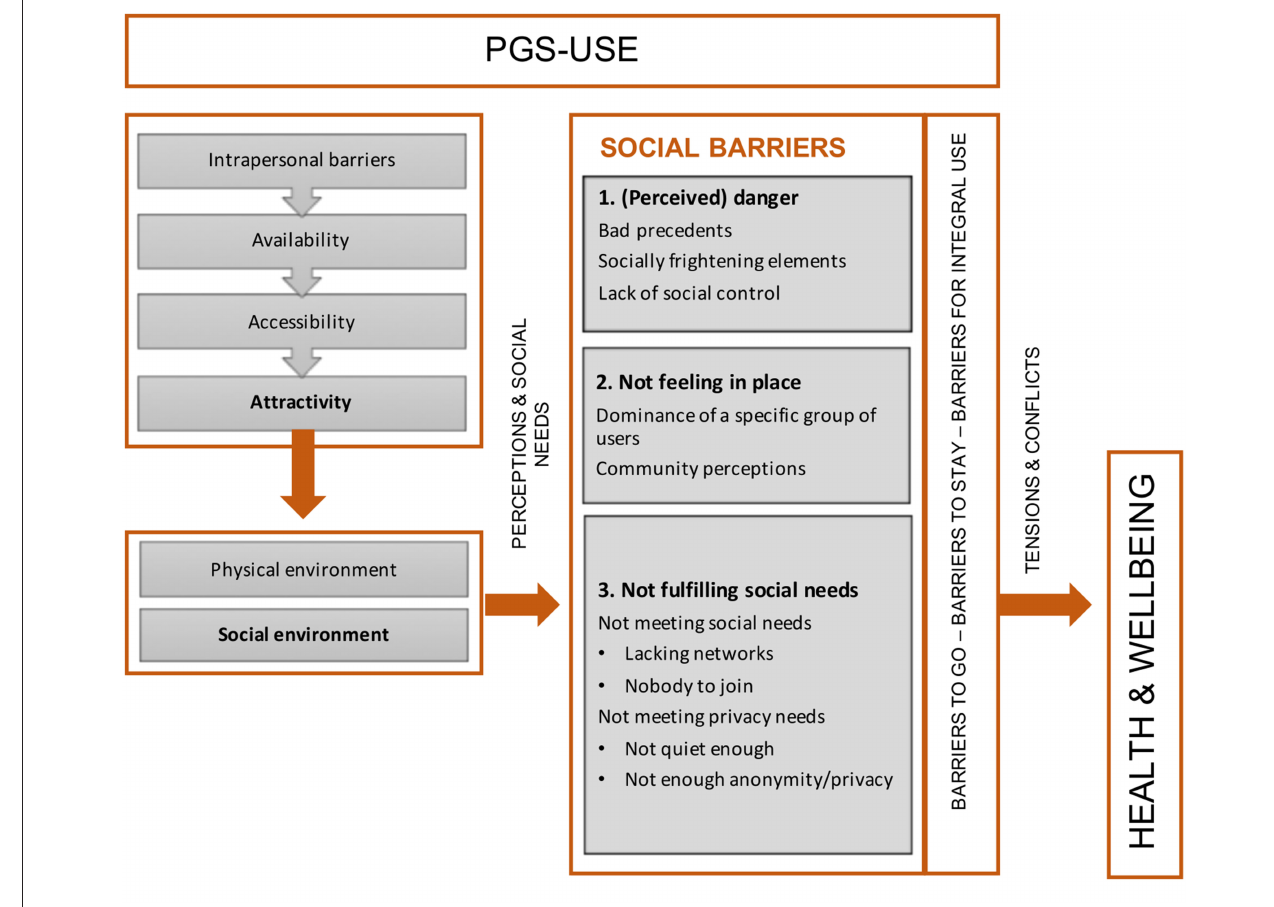
FIGURE 1 | Overview of identified social barriers for PGS